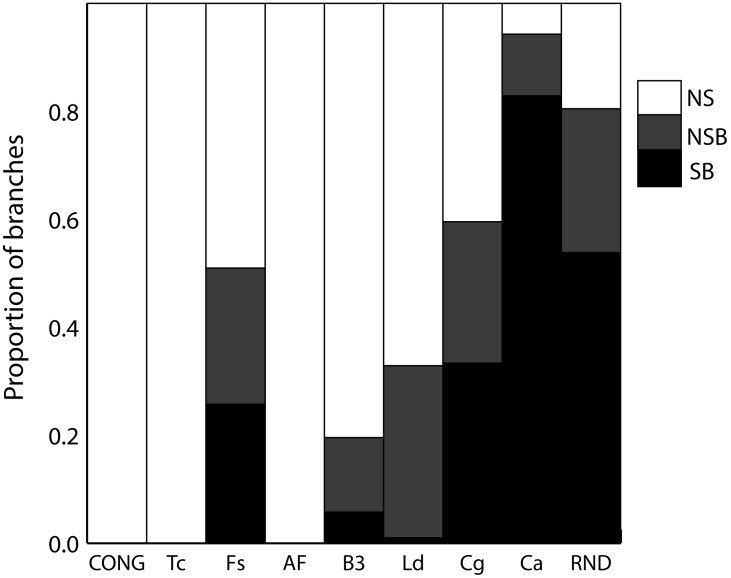
Significance distribution of NJ-LILD test for standardized datasets.The color scale-bar represents the p-value significance level for the test. NS, not significant at alpha = 0.05; NSB, not significant after Bonferroni correction; SB, significant after Bonferroni correction.